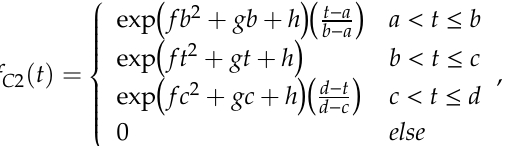
Figure 10. Water column scattering model.